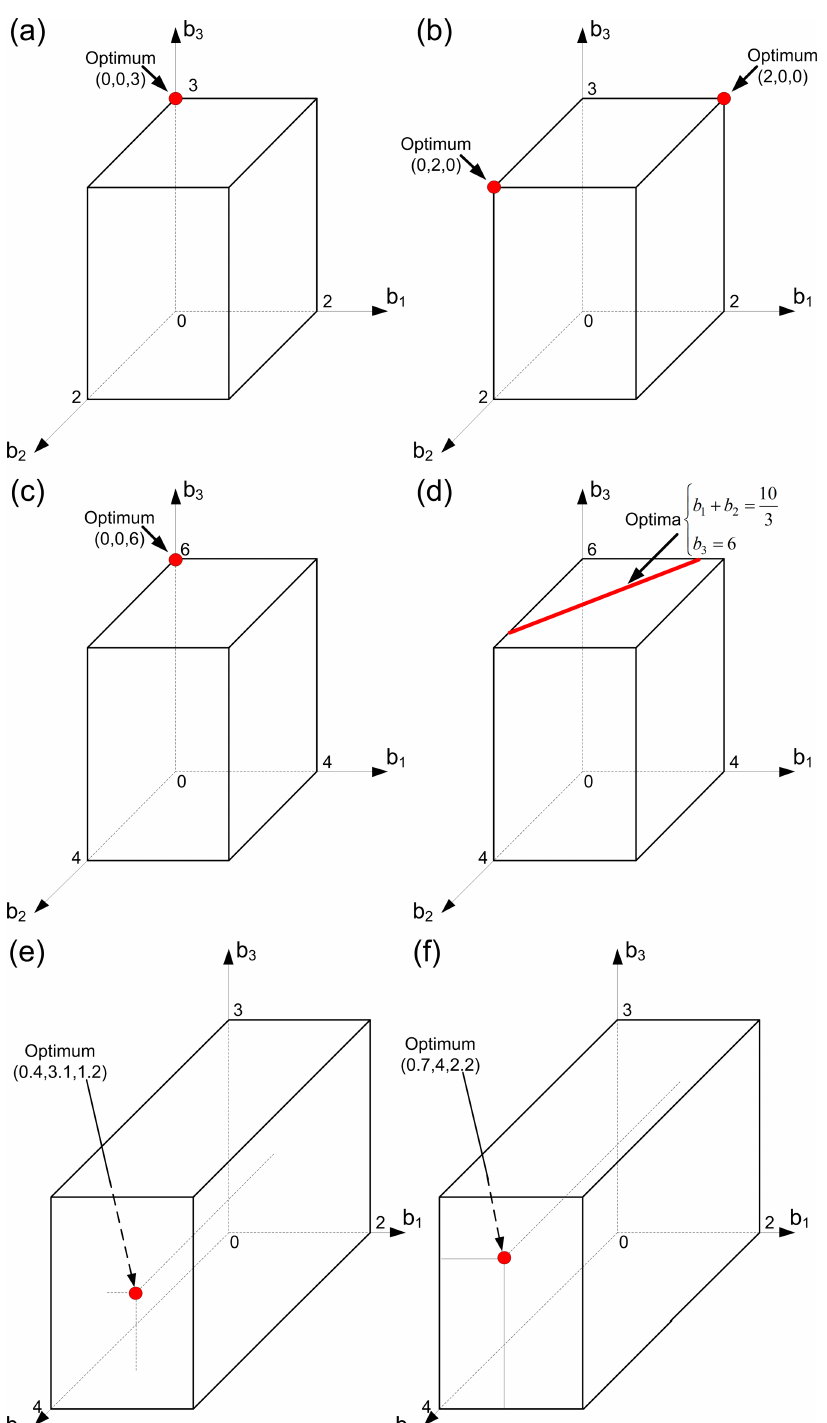
Fig 8. Evolution of germ and soma in colonies with: Positional effects, different curvatures of trade-off functions and different ‘importances’ of viability and fecundity (Case 1). Here we assume that we have three groups of cells within the colony such that all cells from each group have the same level of fecundity and the same level of viability (i.e., we have three ‘aggregate’ cells in the colony). The following 3-D panels are shown. In all panels, α = 1. In panels (a), (c) and (e), β = 2. In panels (b), (d) and (f), β = 0.5. In panels (a) and (b), φ 1 = ( b 1 -2) 2 , φ 2 = ( b 2 -2) 2 and φ 3 = ( b 3 / p - 3) 2 . In panels (c) and (d), φ 1 = 4- b 1 , φ 2 = 4- b 2 and φ 3 = 2- b 3 /3. In panels (e) and (f), φ 1 = 4- b 12 , φ 2 = 2- b 22 /8 and φ 3 = 3- b 32 /3. Optimal strategies of the colony are colored in